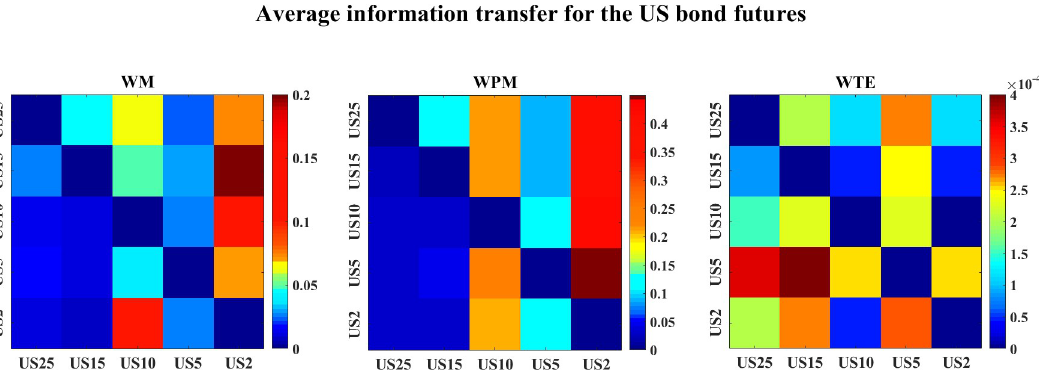
Fig 30. The color-map for the average information transfer values of the US bond futures. The three color-graphs present the color-map for the average WM (left), WPM (middle) and WTE (right) information transfer for the US bond futures. The direction of interaction is read from the row channel to the column channel for each